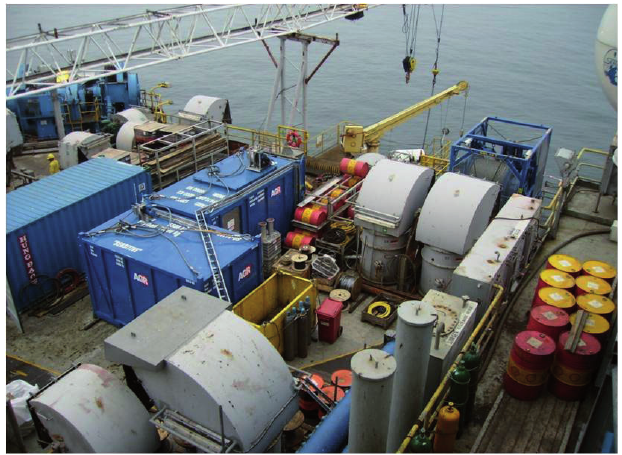
Figure 5. The AGR riserless mud recovery system deployed on an oil and gas exploration